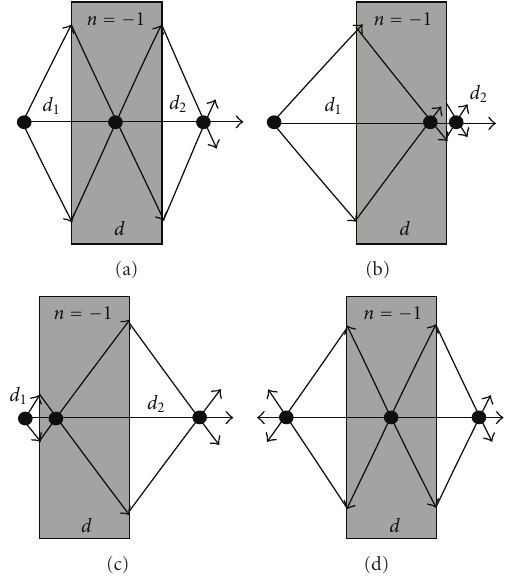
Figure 8: Ray tracing illustration of the flat lens made of an isotropic homogeneous medium with index of refraction n = − 1. d 1 is the distance between the source and the first interface, and d 2 is the distance between the image point and the second interface, d is the thickness of the slab. (a) d 1 = d/ 2, (b) d 1 > d/ 2, (c) d 1 < d/ 2, (d) source is placed inside of the